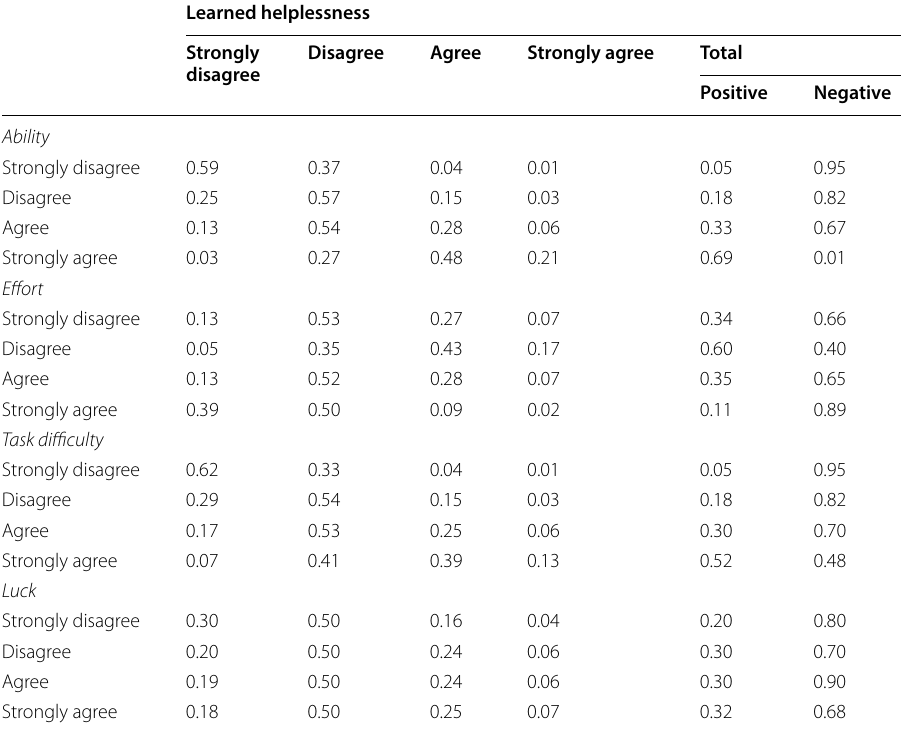
Table 7 Finnish students’ probability to agree/disagree with learned helplessness by attribution